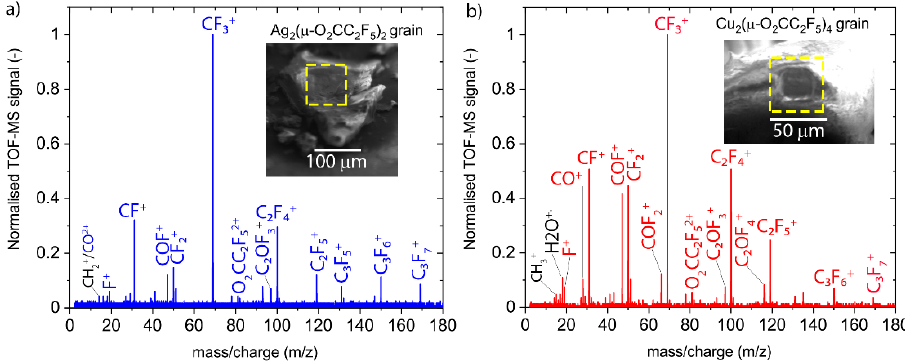
Figure 4. Accumulated FEBiMS spectra of grains obtained by 10 keV and 30 nA electron irradiation of ( a ) silver (I)-pentafluoropropionate and ( b ) copper (II)-pentafluoropropionate. Insets show the 55 ◦ tilt SEM pictures of irradiated grains with visible square-shaped holes created due to irradiation with electrons. Note that there is no mass peak at m / z = 163 corresponding to ESD of the singly charged parent carboxylate ligand fragment ( µ -O 2 CC 2 F 5 ), but there is a visible peak at m / z = 81.5 which corresponds to its doubly ionized state.